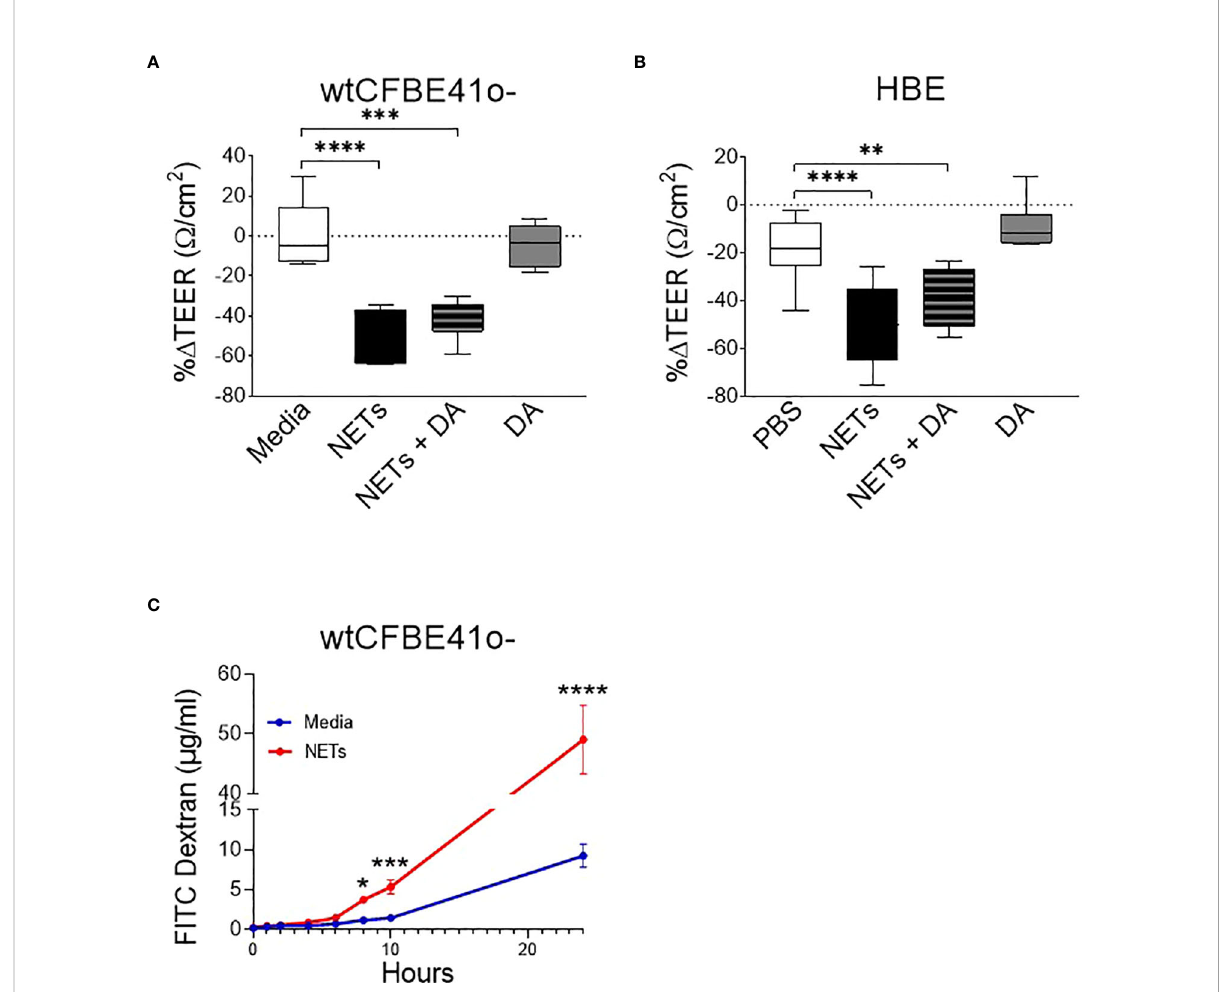
FIGURE 1 Neutrophil extracellular traps (NETs) disrupt epithelial barrier function. (A) wtCFBE41o- grown to con fl uence and (B) primary normal human epithelia (HBE) grown at air-liquid interface (ALI) were exposed to media or PBS control (respectively), 5µg/ml NETs, NETs+0.5µg/ml dornase alpha (DA), or DA in the apical compartment for 18h in triplicate wells. Transepithelial electrical resistance (TEER) was measured pre and post exposure in duplicate per well and expressed as a percent change. Data analyzed by one-way ANOVA followed by Bonferroni ’ s multiple comparisons test. (experiments=3, HBE donors=3, NET donors=4). (C) Apical to basolateral fl ux of FITC labeled dextran across wtCFBE41o- exposed to media control or NETs for 0-24h. Data analyzed by Least Squares Means, F-test=264.58, ****p<0.0001 from 8-24 hours (experiments=2, NET donors=2). *p<0.05, **p<0.01, ***p<0.001,